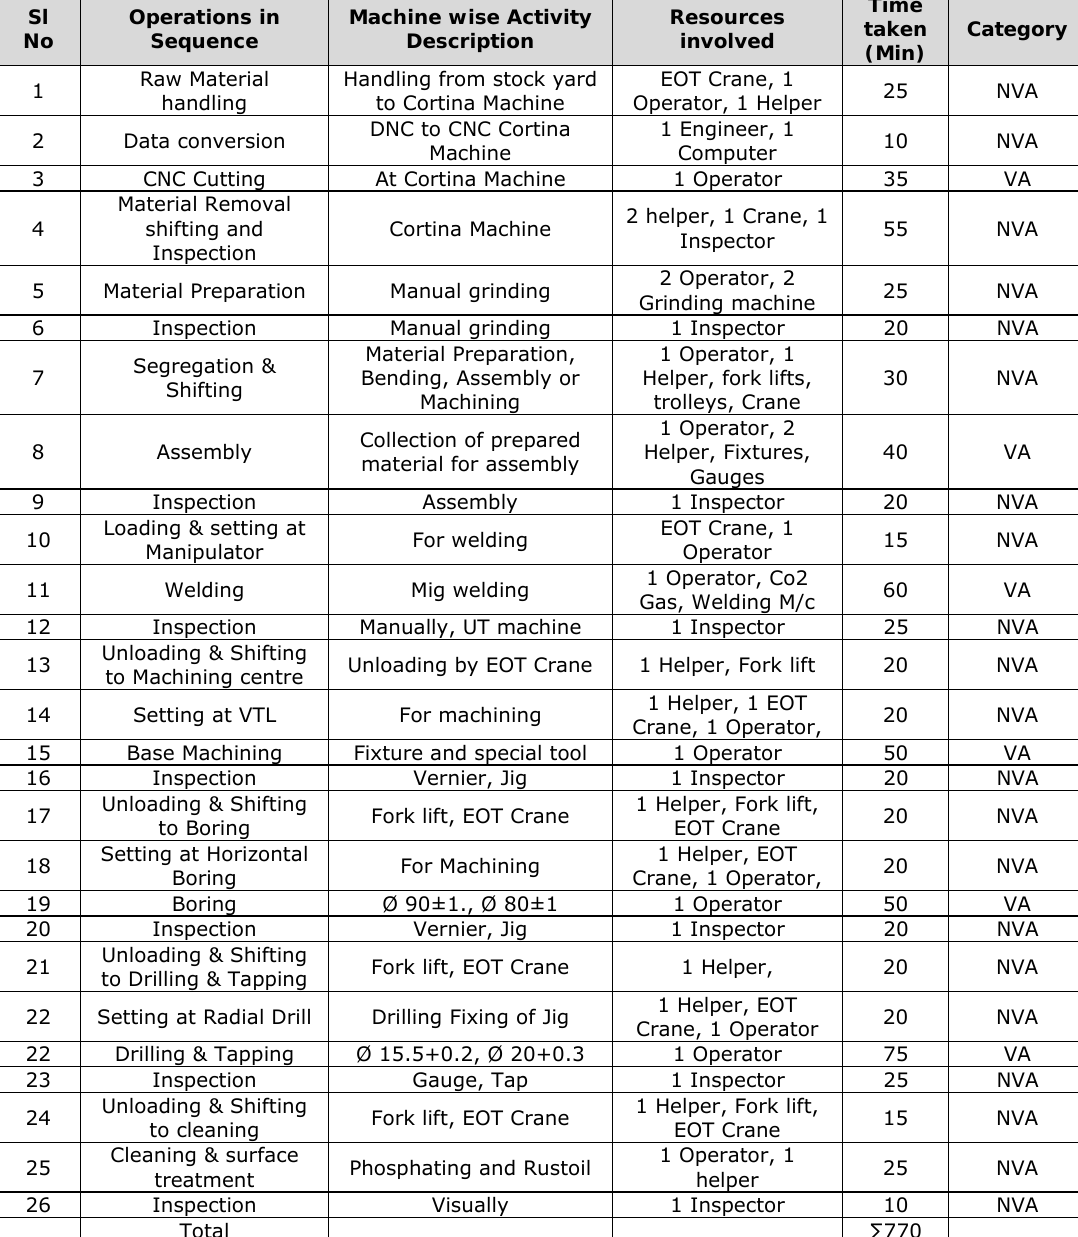
Table 2. “Value stream mapping before root cause